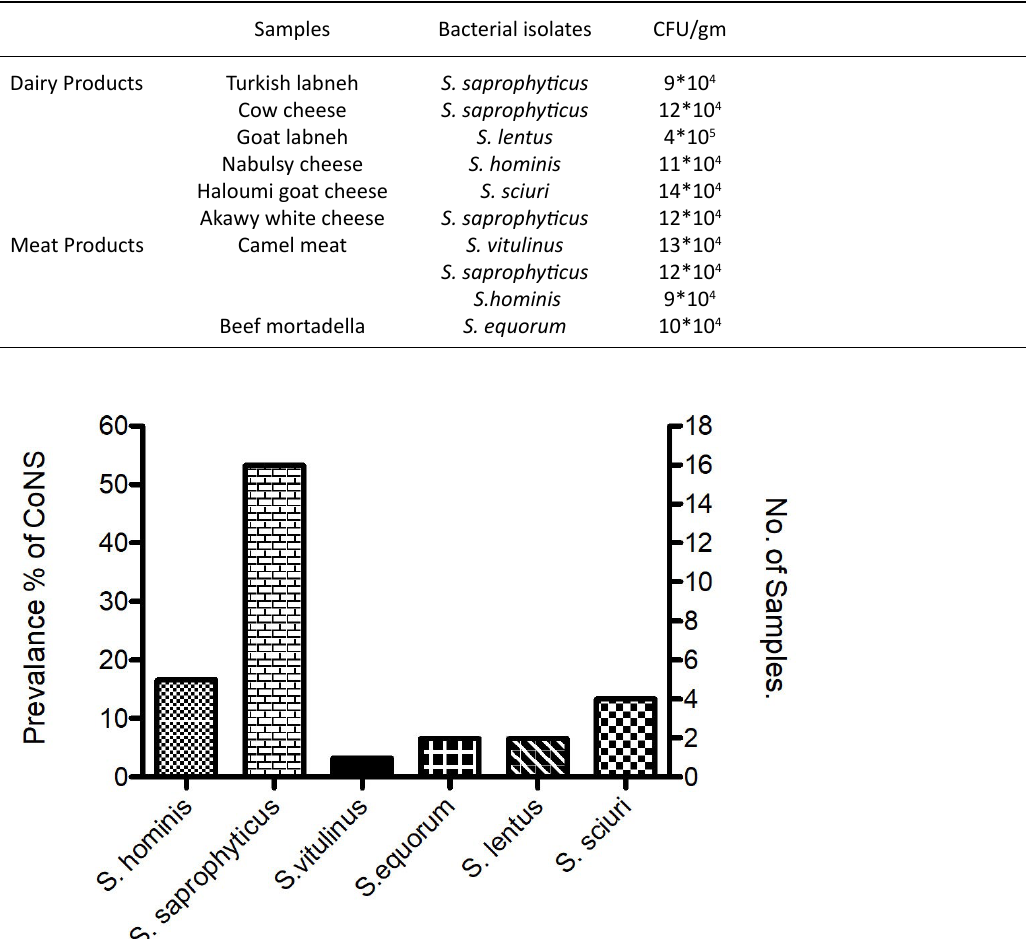
Table 3. Total counts of Staphylococcus spp. in meat and dairy products (CFU/gm)